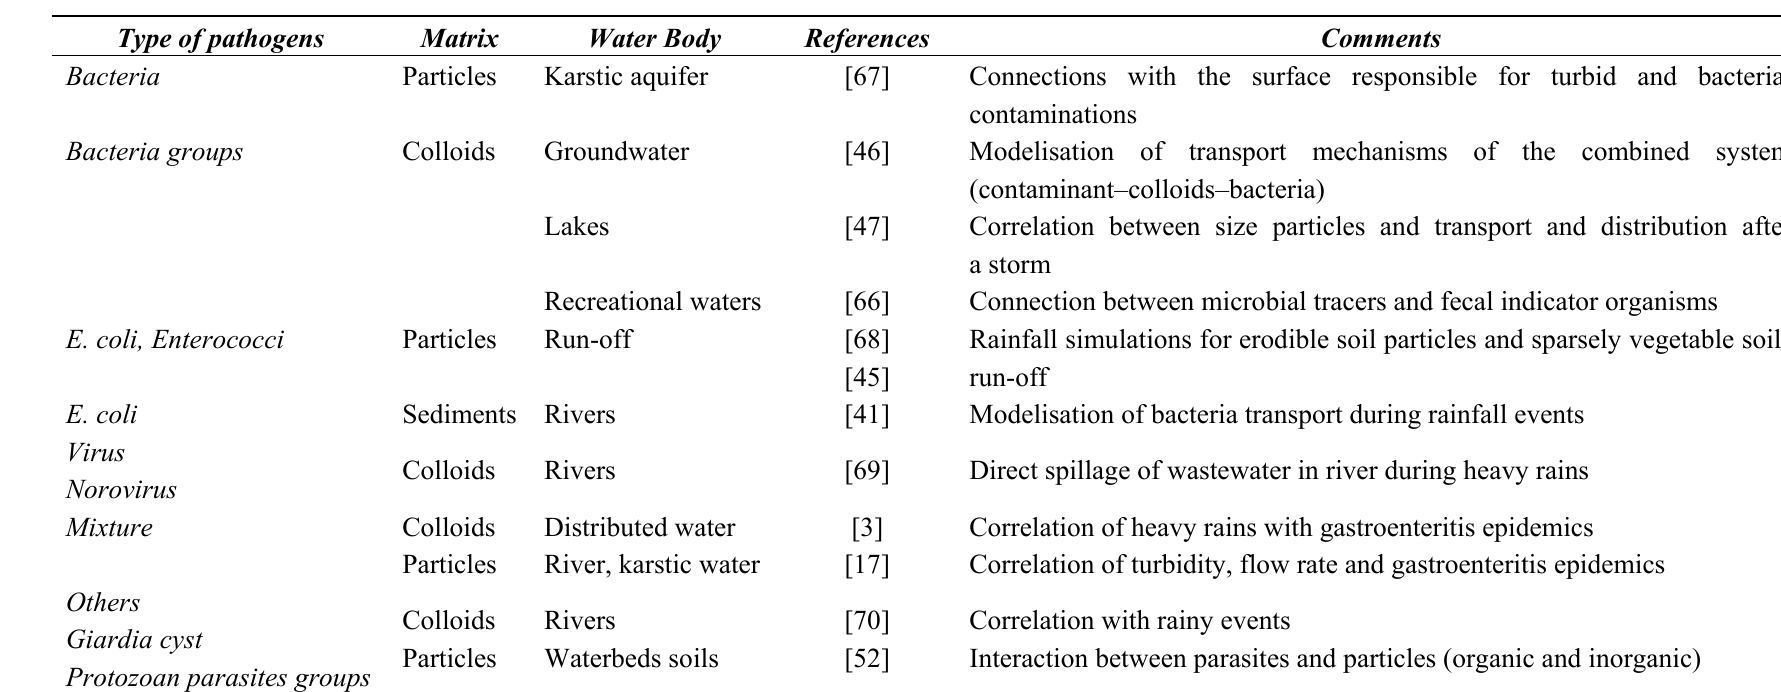
Table 1. Pathogens interactions studies with particulate and colloidal phases in the aquatic